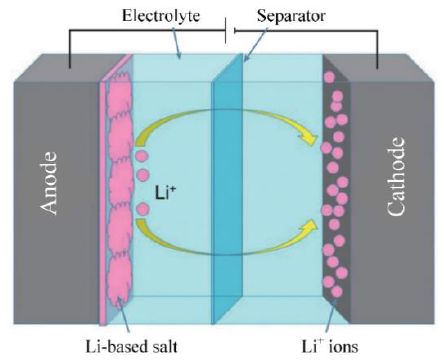
Figure 61. Schematic diagram of a hybrid supercapacitor, which combines the principles of EDLC and pseudocapacitors [59].